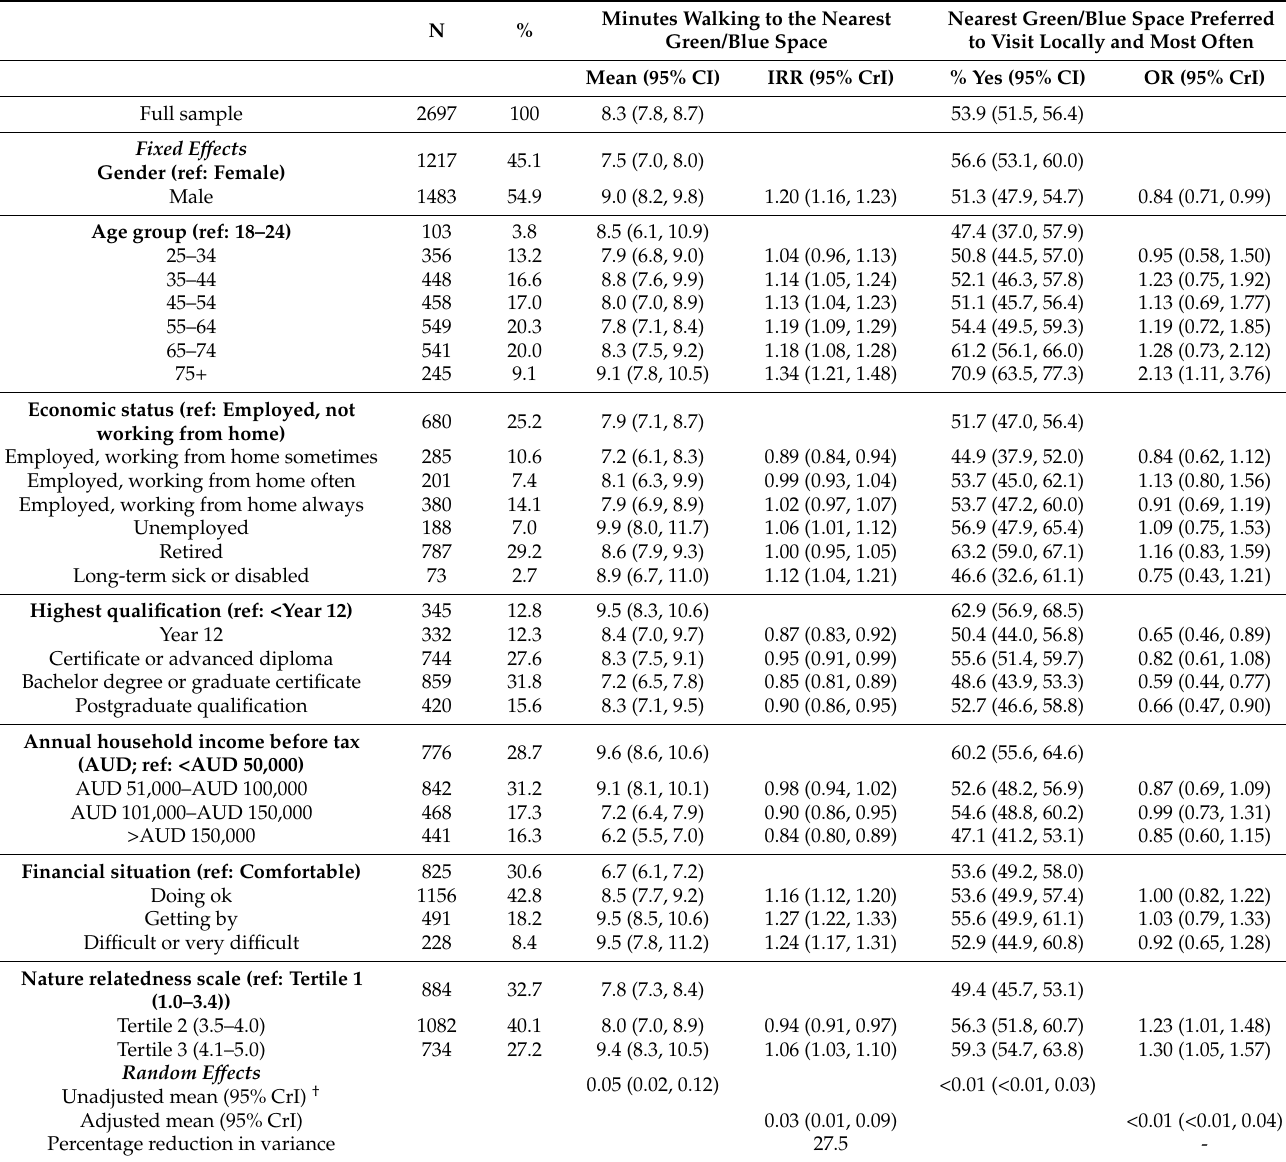
Table 1. Associations with access to the nearest and preferred green or blue spaces during the COVID-19 pandemic. Minutes Walking to the Nearest Nearest Green/Blue Space Preferred N % Green/Blue Space to Visit Locally and Most Often Mean (95% CI) IRR (95% CrI) % Yes (95% CI) OR (95%